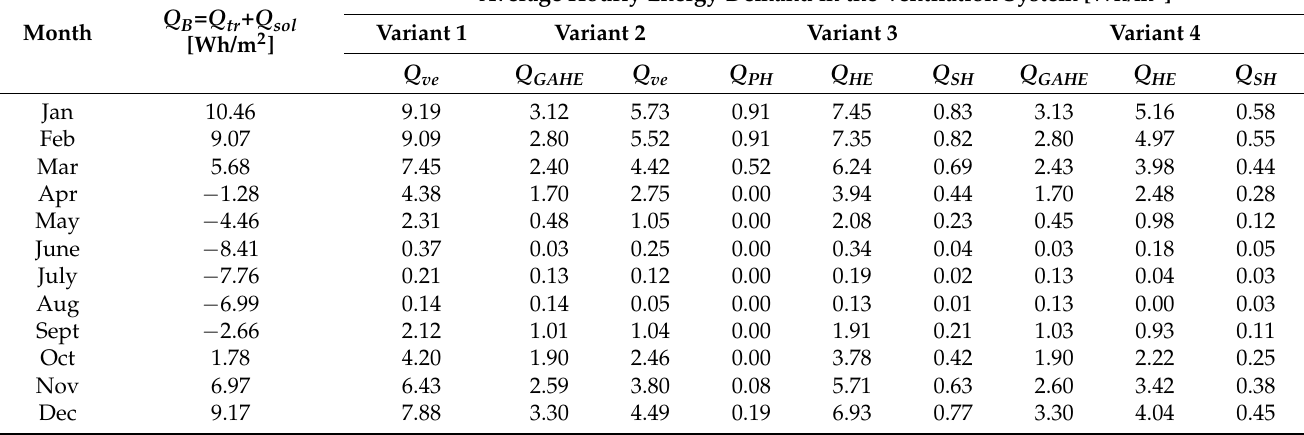
Table 1. Average hourly energy loads per 1 m 2 of floor area [Wh/m 2